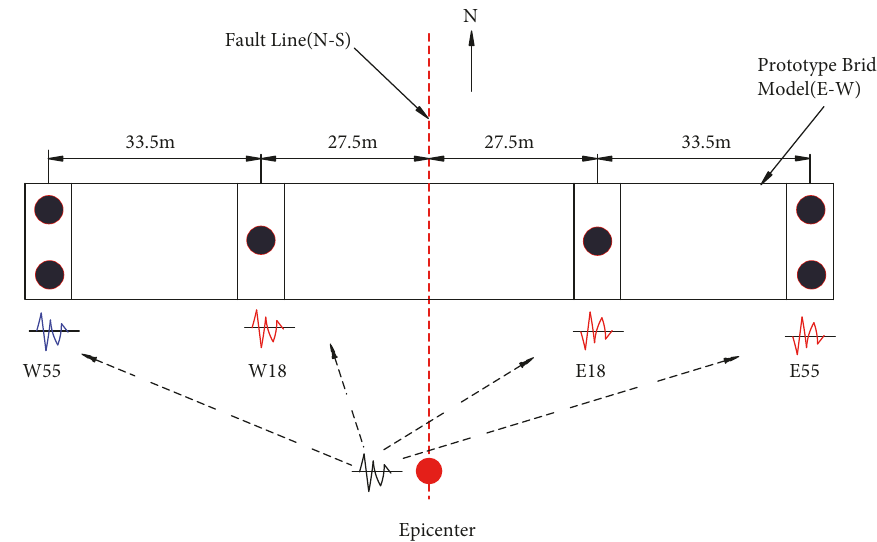
Figure 6: Bridge and fault locations for ground motion simulation.